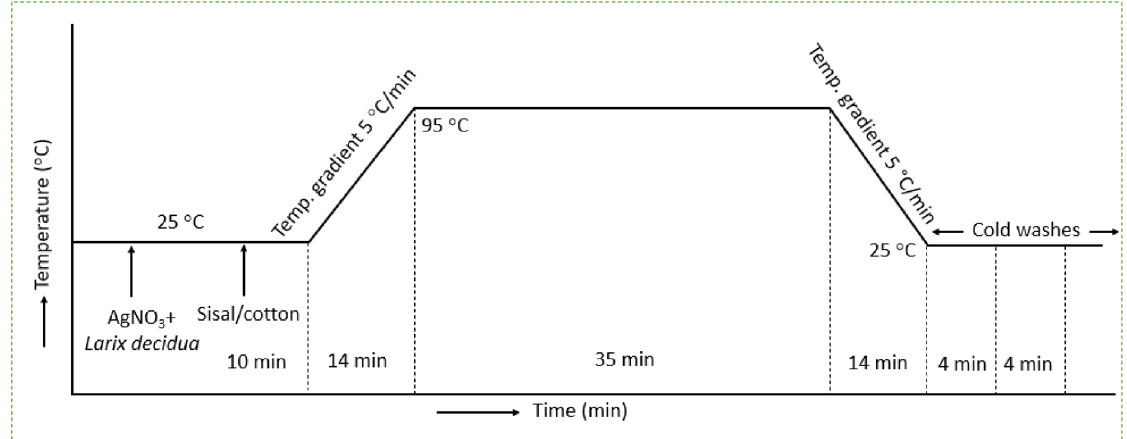
Figure 2. Operational procedures of green AgNPs deposition mechanism on sisal/cotton interwoven